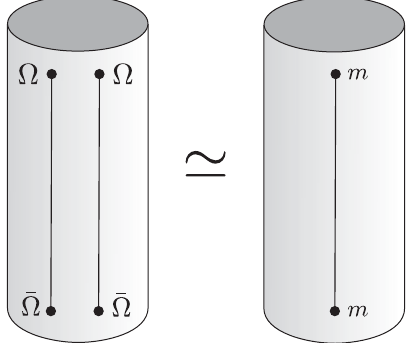
FIG. 2. Illustration of the flux-fusion anomaly test using dimensional reduction to a d ¼ 1 cylinder. The Z 2 ⊂ U ð 1 Þ flux Ω is threaded twice along the left-hand cylinder, while m is threaded along the right-hand cylinder. Because of the fusion rule Ω 2 ¼ m , these two systems are in the same d ¼ 1 SPT